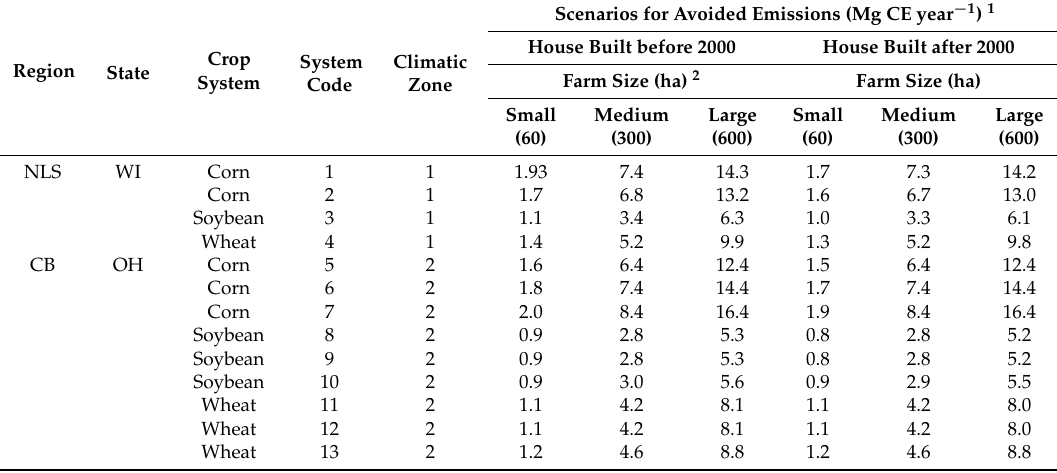
Table A8. Potential of windbreaks on different faming scenarios for avoiding carbon emissions.